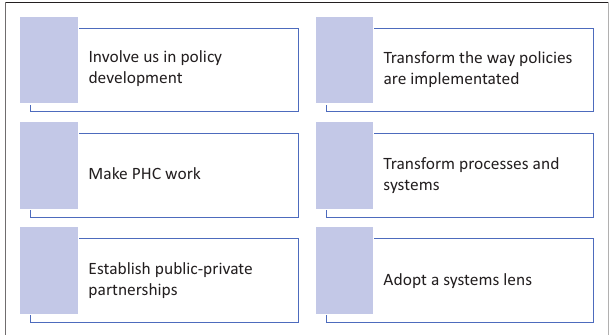
FIGURE 3: Diagrammatic summary of findings: Health system transformation rather than health system